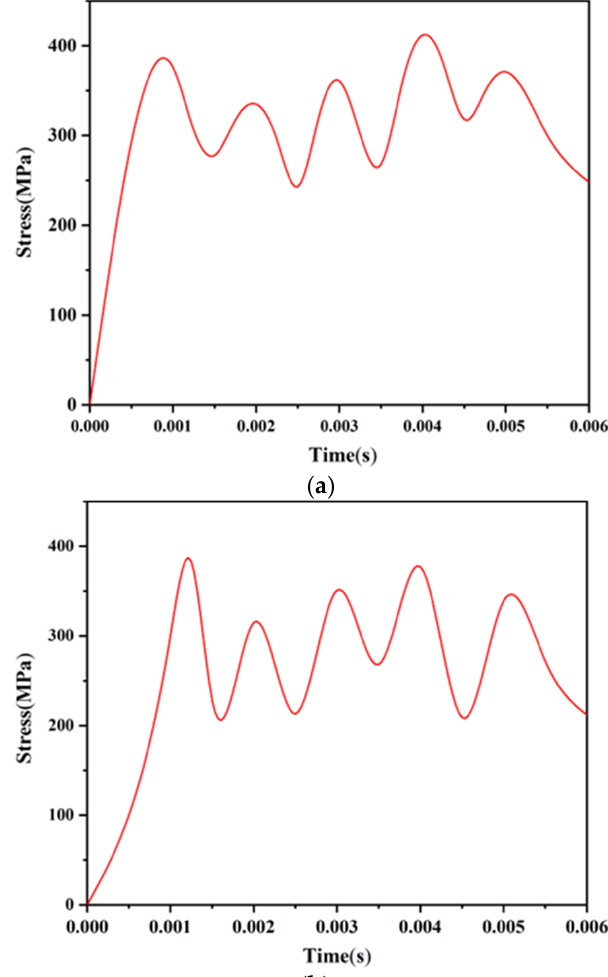
Figure 16. Finite element model.